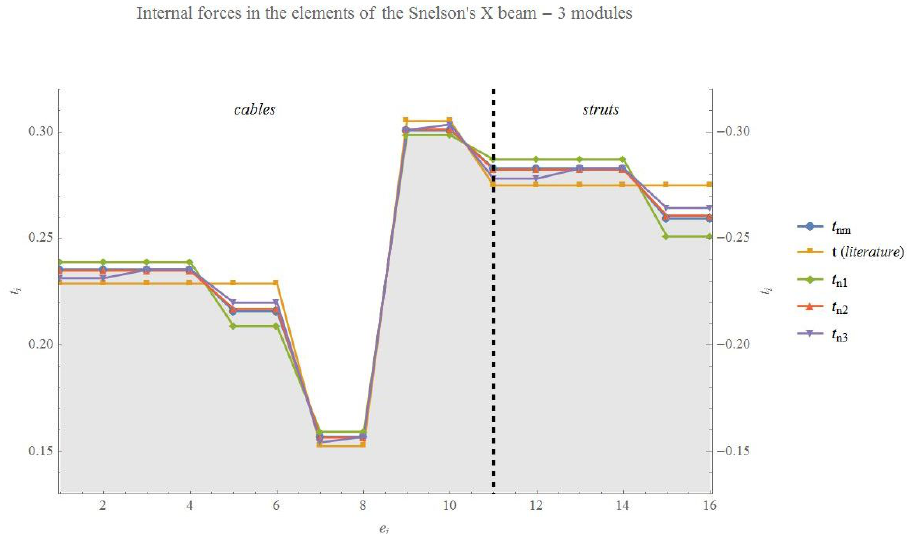
Figure 7: Internal forces in the elements of the tensegrity Snelson’s X beam with three modules as the axial stiffness of the elements vary (note that the origin of the vertical axes is 0.13) Table 5: Force densities of the elements of the Snelson’s X beam with three modules, normalized with respect to the force density of the